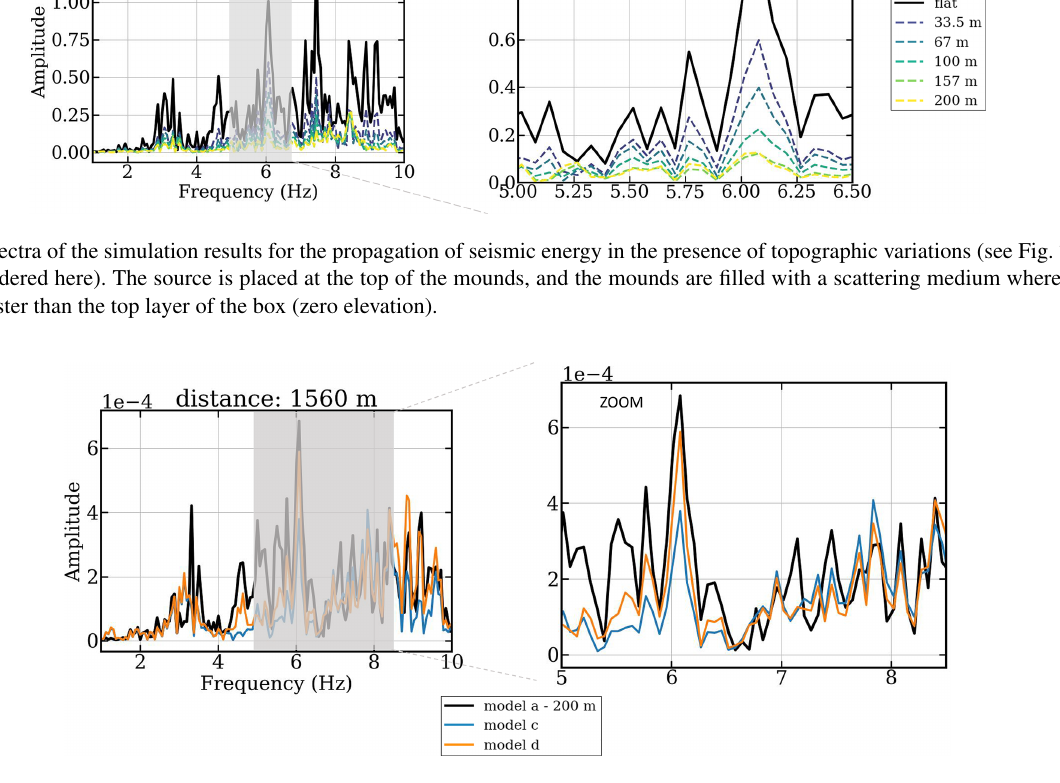
Figure 9. Spectra for the simulation results for the seismic noise for the models with complex topographic variations (orange and blue lines) in comparison with the 200km high mound (black line). The source (WT) is placed at the top of the hill, and the recording seismic station is placed 1560km behind the WT. The models are presented in Fig. 7a, c, and d with 200m height. We include scatters for which the rms velocity variation is the same as the top layer of the box (zero